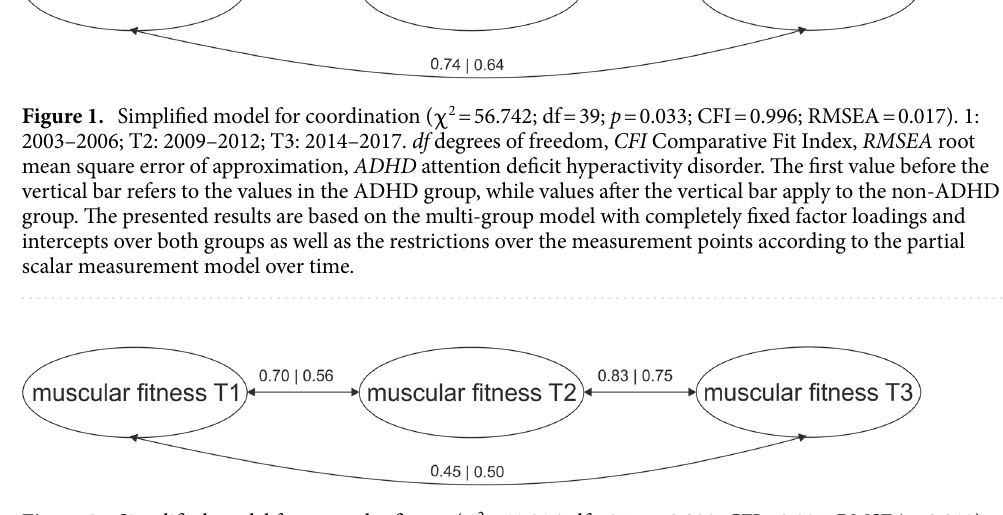
Figure 2. Simplified model for muscular fitness ( χ 2 = 41.316; df = 27; p = 0.038; CFI = 0.997; RMSEA = 0.019). T1: 2003–2006; T2: 2009–2012; T3: 2014–2017. df degrees of freedom, CFI Comparative Fit Index, RMSEA root mean square error of approximation, ADHD attention deficit hyperactivity disorder. The first value before the vertical bar refers to the values in the ADHD group, while values after the vertical bar apply to the non-ADHD group. The presented results are based on the multi-group model with completely fixed factor loadings and intercepts over both groups as well as the restrictions over the measurement points according to the partial scalar measurement model over